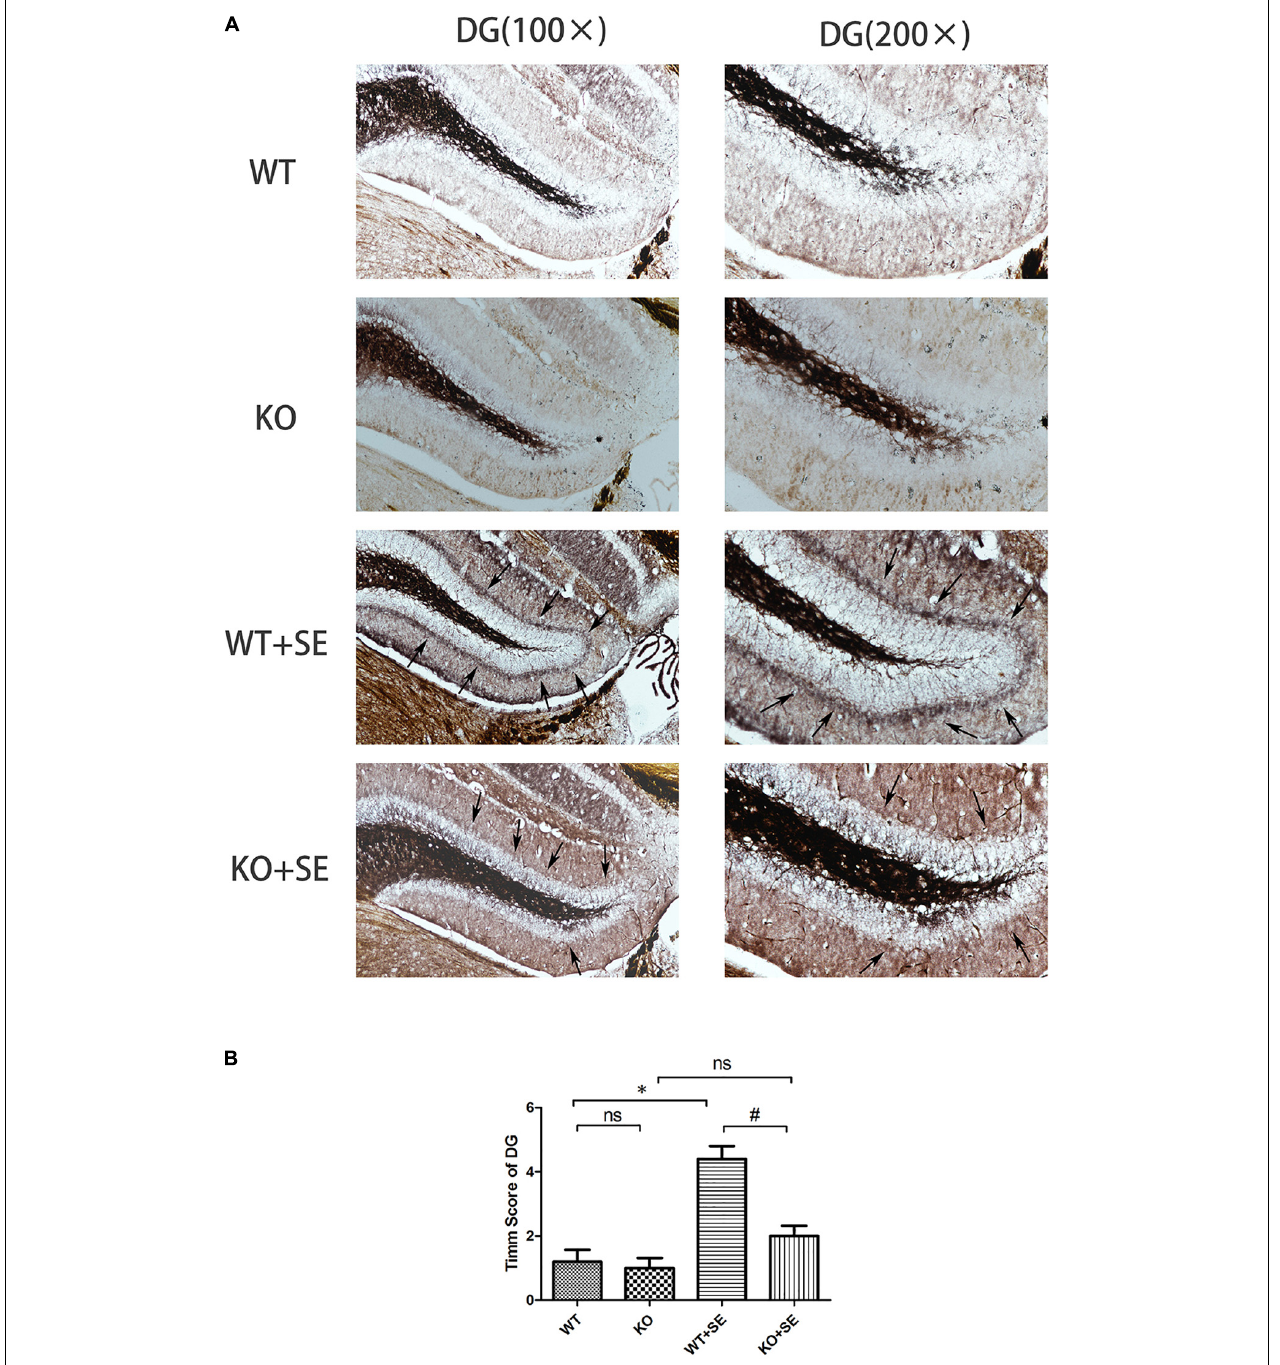
FIGURE 4 | Juvenile seizures increased mossy fiber sprouting (indicated by the arrows) in the inner molecular layer of the dentate gyrus of WT mice, but this effect was attenuated in KO mice. (A) Timm staining in dentate gyrus subfield; (B) Timm score analysis. ∗ P < 0.05, compared to WT group, # P < 0.05 compared to WT + SE group, ns means no statistical